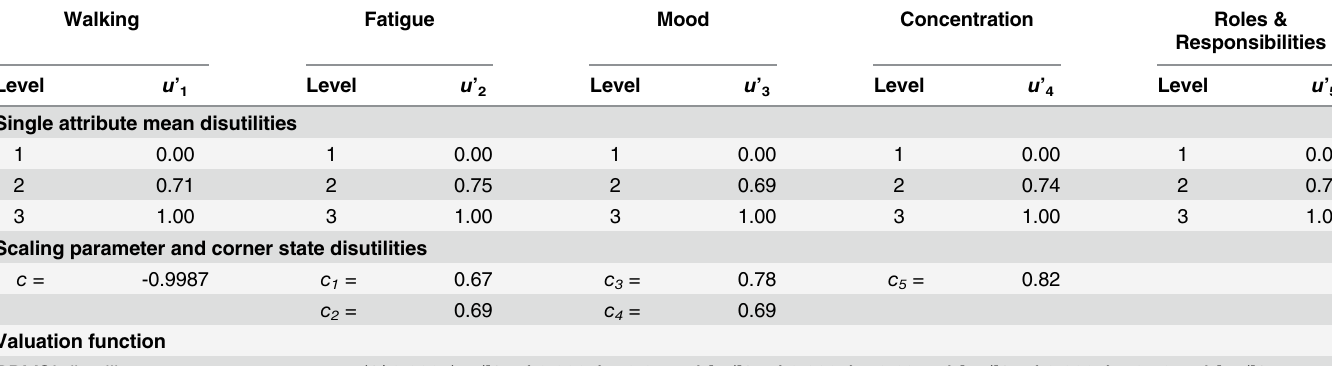
Table 7. PBMSI MAUF D developed based on rating scale values obtained from the Development sample.